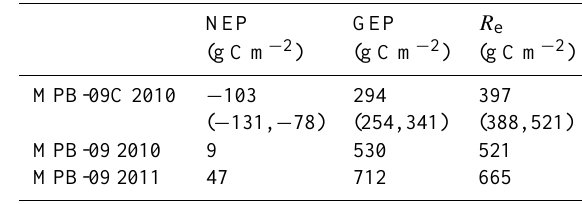
Table 5. Net ecosystem production (NEP), gross ecosystem photo- synthesis (GEP) and ecosystem respiration ( R e ) totals for the clear- cut (MPB-09C) and the partially harvested stand (MPB-09) during the summer (10 June–22 September) of 2010 and 2011 ∗ . Values in parentheses show the lower and upper 95% confidence intervals for the growing season totals derived from Monte Carlo